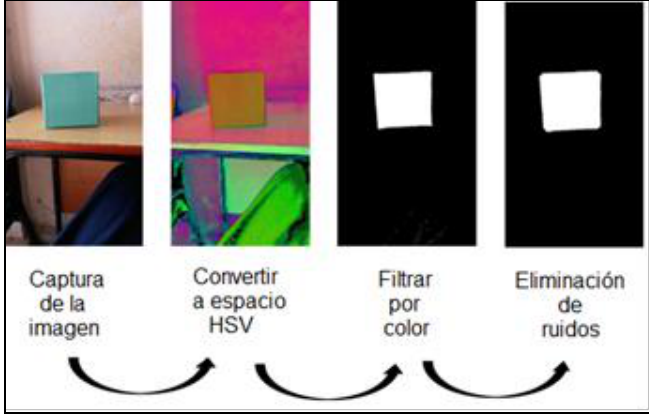
Figura 5: Proceso del reconocimiento del objeto por color. Fuente: Los autores,